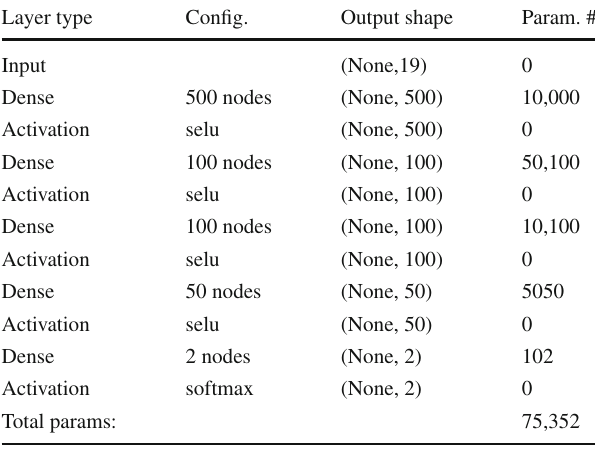
Table4 Networkarchitecturefortheoracleinthe“RandomForestwith an infinite pool” and the “QBDC with an infinite pool” experiments Layer type Config. Output shape Param. #